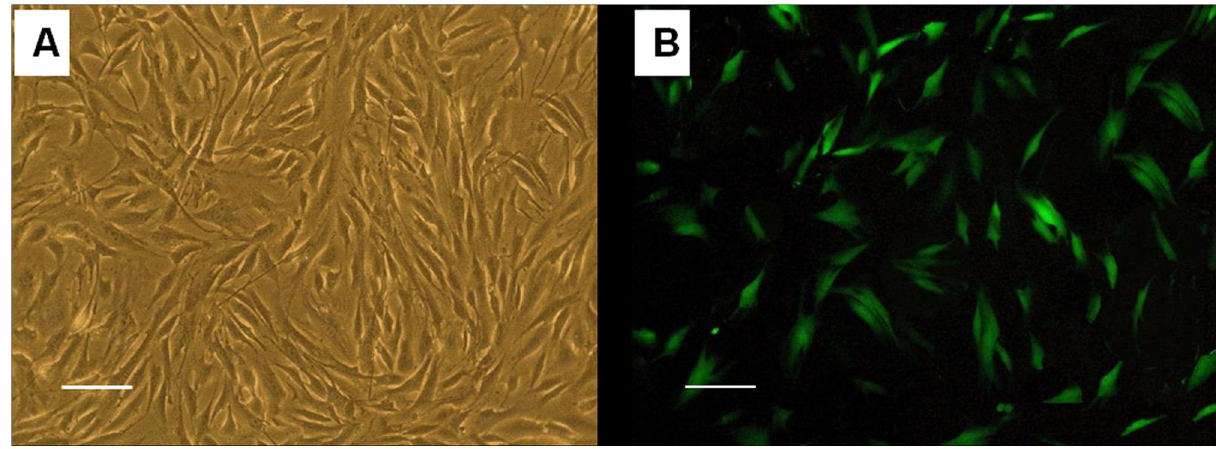
Figure 1. rASCs culture and GFP labeling. (A) rASCs at four passages, which appears to be a fibroblast-like uniform shape. (B) Fluorescence microscopic photograph of GFP labeled rASCs in Figure 1A. Most cells were GFP positive (Bar scales: 100 µm).. doi: